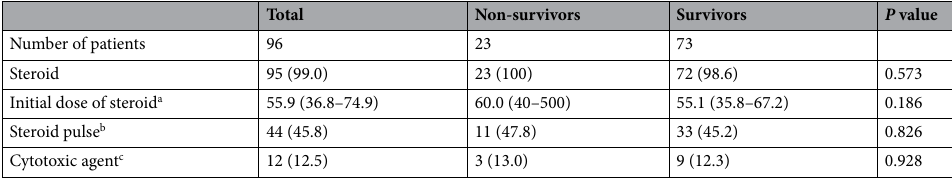
Table 2. Comparison of treatment for AE-ILD during hospitalization. Data are presented as median (interquartile range) or number (%). AE-ILD acute exacerbation of interstitial lung disease. a Methylprednisolone (mg); b ≥ 500 mg/day methylprednisolone for 3 days; c Azathioprine, cyclosporine, or cyclophosphamide.